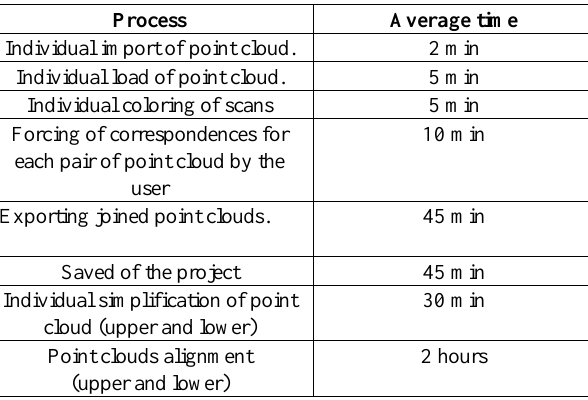
Table 1. Average processing times using LiDAR software. Process Average time Individual import of point cloud. 2 min Individual load of point